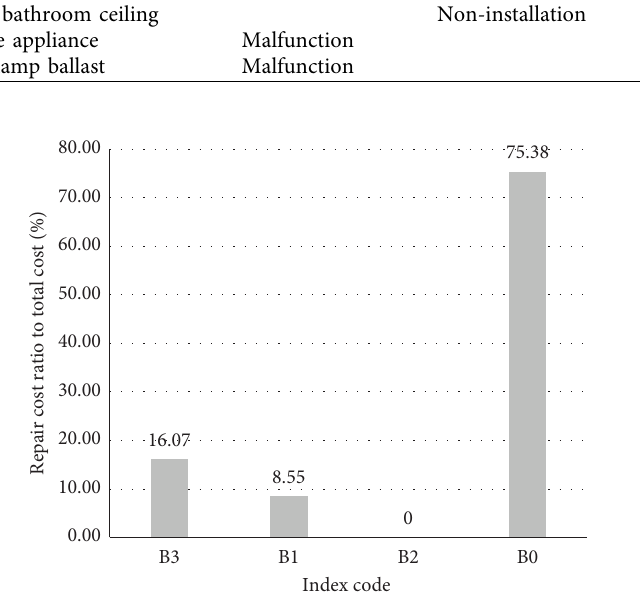
Figure 9: Pareto graph on repair cost of index B . Table 4: Quality management item of index C .